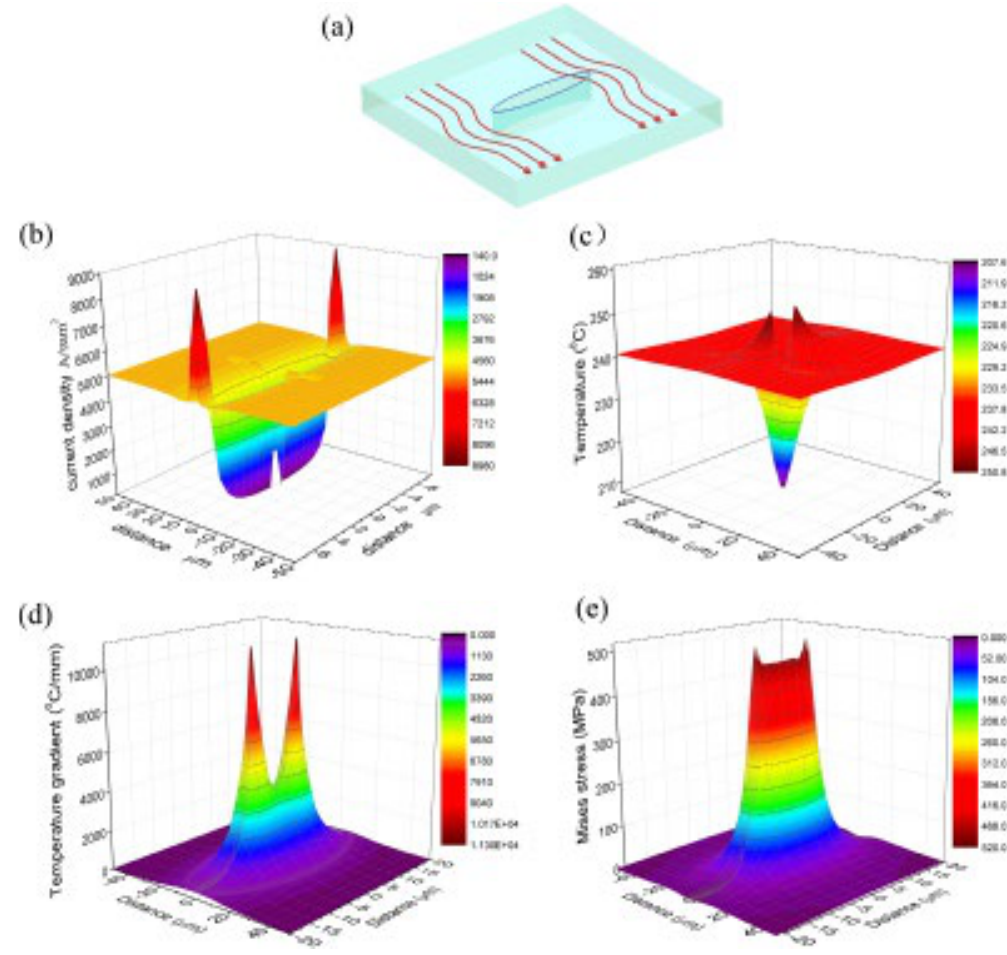
Figure 1. Electric current redistribution and localized energy landscape induced by the microcrack at t = 26 μ s ( a ) Schematic of electric current distribution. ( b – e ) the three-dimensional representation of the current density, temperature, temperature gradient and Mises stress on a cut plane across the microcrack,